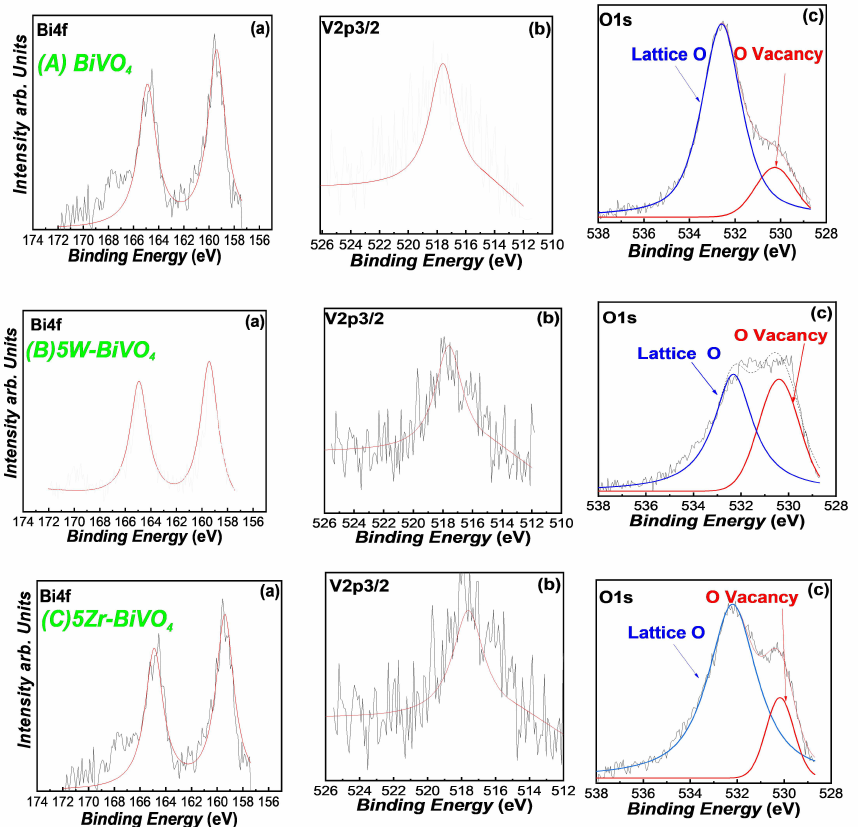
Figure 3. XPS spectra of ( A ) pristine FSP-made BiVO 4 , ( B ) 5 W-BiVO 4 and ( C ) 5 Zr-BiVO 4 (( a ) Bi 4f , ( b ) V 2p and ( c ) O 1S